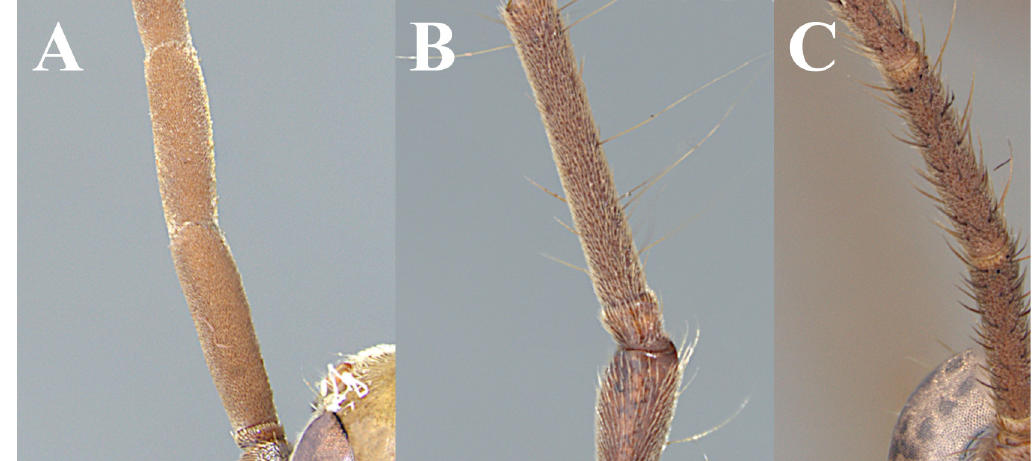
Fig. 10. Detail of antenna pilosity. A . Dinoponera grandis (Guérin-Menéville, 1838). B . D. quadriceps Kempf, 1971. C . Dinoponera morphospecies